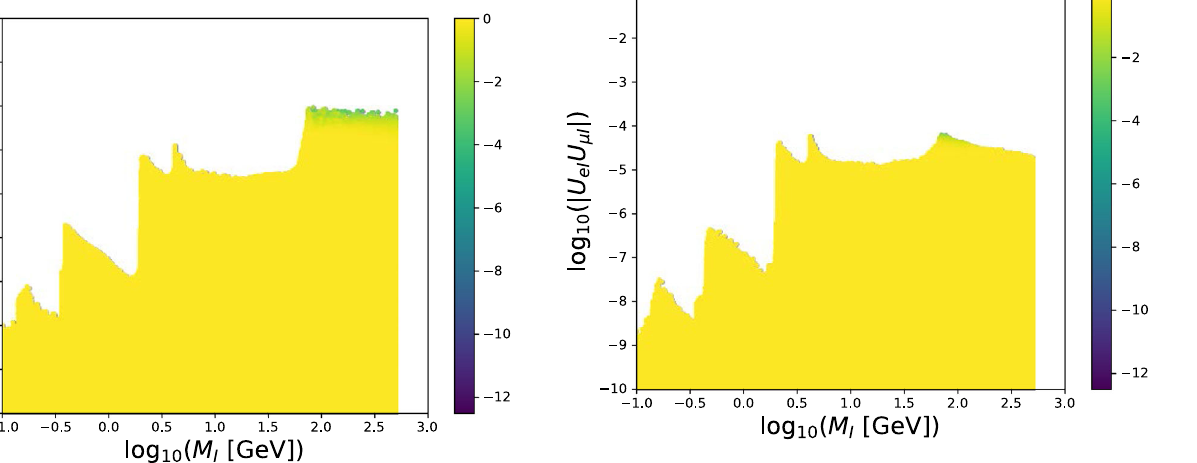
Fig. 33 Partial likelihood from sin θ W , in the M I − | U μ I | 2 plane